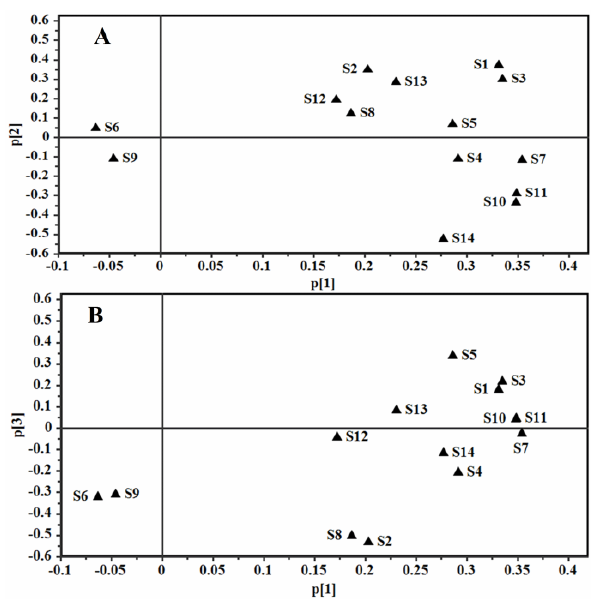
Figure 5. Loadings plot of PCA for 14 ginsenosides in their HPLC profiles of 66 samples of GRR (S1: